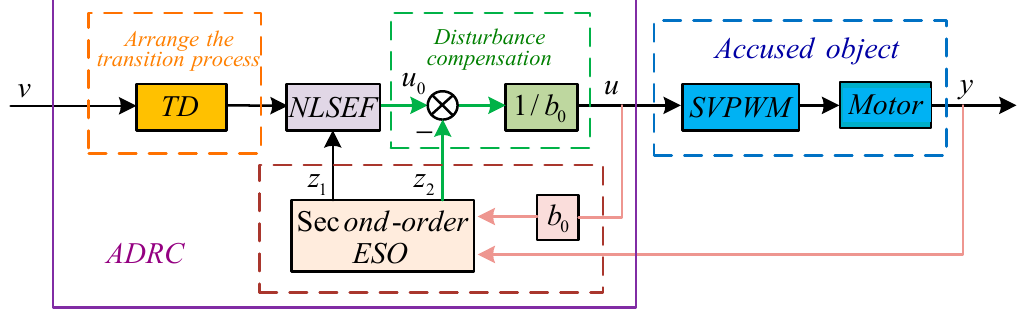
Figure 4. Coupling structure of an asynchronous motor.